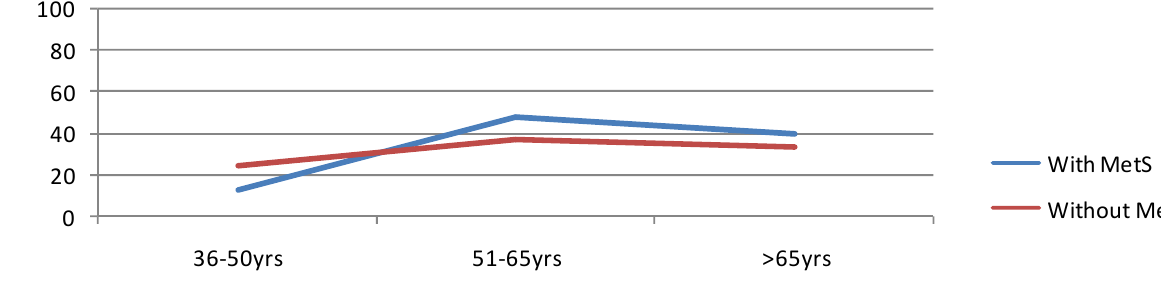
Table 1. Comparison of socio-demographic variables in all the study subjects